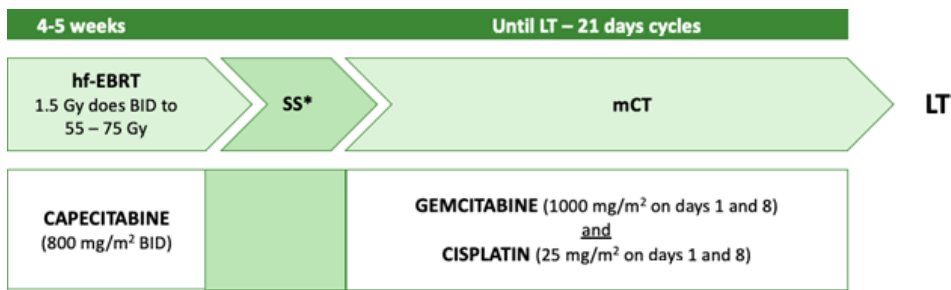
Figure 3. Mayo Clinic neoadjuvant protocol. EBRT: external beam radiotherapy; BT: brachytherapy; SL: staging laparotomy; LT: a liver transplant. * with biopsies of at least common hepatic artery and distal bile duct lymph nodes.